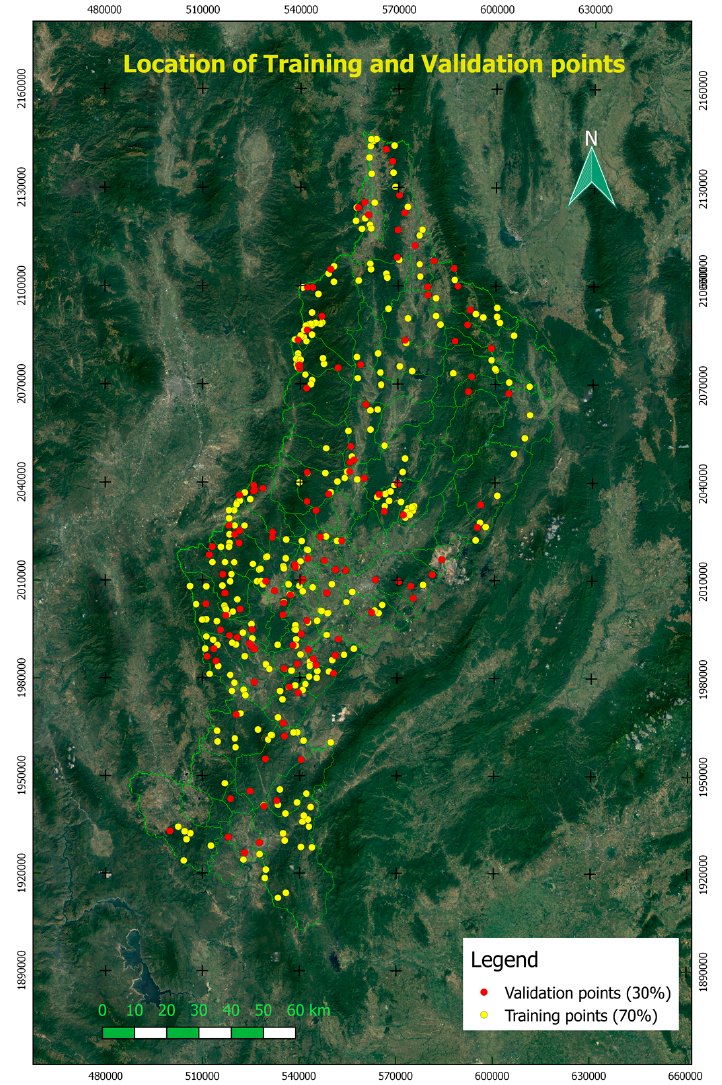
Figure 3. Location of training and validation points in Lampang. A total 458 points, 320 points (70%) randomly selected for training data set and 138 points (30%) for validation data samples.